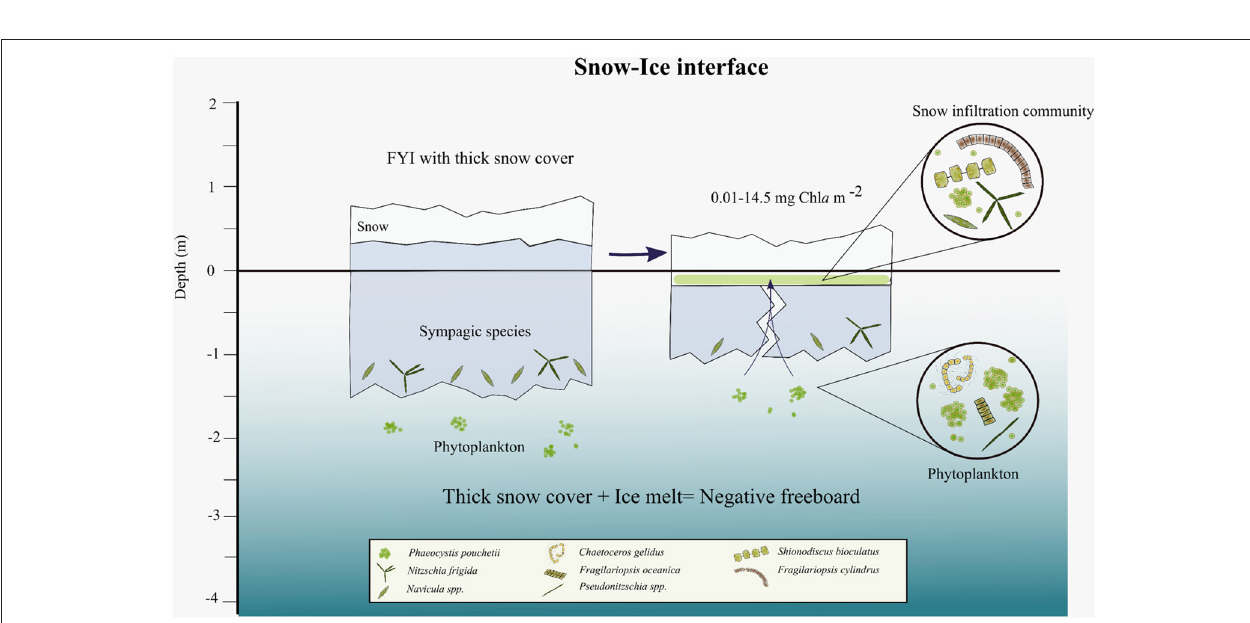
FIGURE 3 | Scheme of snow-ice interface habitat with algal biomass and simplified taxonomic composition. The snow infiltration community is established when thin ice with a thick snow cover starts melting and cracks appear in the ice that enable seawater to infiltrate into the snow-ice slush layer.